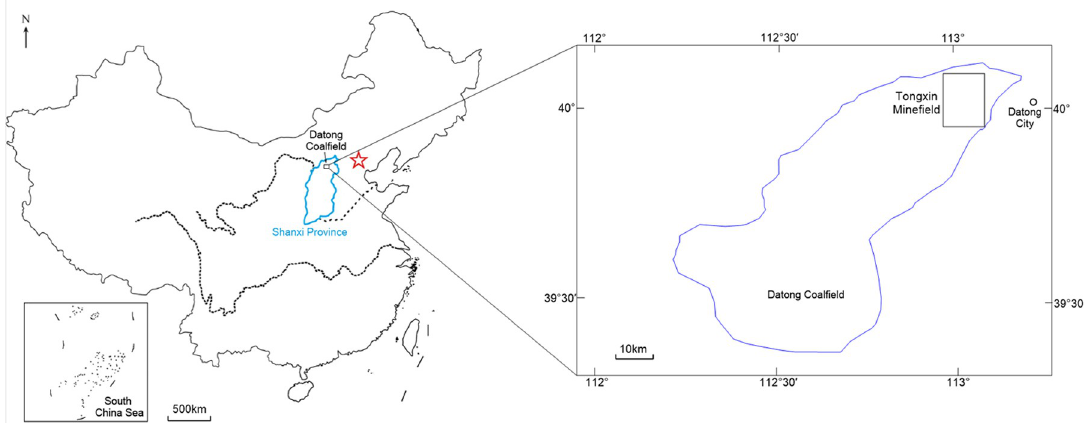
Fig 2. Locations of the Datong Coalfield and Tongxin